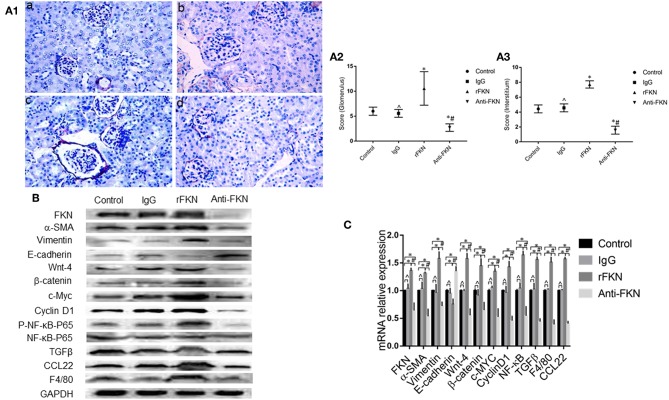
FKN is involved EMT and fibrosis via the Wnt/β-catenin pathway in the kidney of MRL/lpr mice. Histopathological features of renal tissue in the MRL/lpr mice model were studied by PASM staining (original magnification, ×400). (a) Control group;(b) IgG group; (c) rFKN group; (d) anti-FKN group. (A1) Assessment of glomerular and renal interstitial pathologies stained with PASM. Glomerular pathology was graded from the sum of scores for glomerular inflammation, thickness of basement membrane, epithelial cell reactivity, crescent formation, and necrosis. Interstitial pathology was graded using the sum of scores for perivascular inflammation and inflammatory cell infiltration. Scores were graded as 0 to 4 (0, none; 1 mild; 2 moderate; 3 moderate-high; 4 high). (A2) the sum of score by PASM staining in the renal glomerular inflammation. (A3) the sum of score by PASM staining in the renal glomerular inflammation. Renal tissue extract (~50 μg) was resolved on SDS-PAGE and western blot analysis was performed using antibodies against FKN, vimentin, α-SMA, E-cadherin, Wnt-4, β-catenin, cyclinD1, and c-Myc. GAPDH was used as an internal control. Total RNA were extracted from renal tissue of mice. Then the RNA was reverse-transcribed into cDNA and the transcripts were quantified using real-time PCR. GAPDH was used as an internal control. NF-kB-P65 was used as an internal control group of P- NF-kB-P65. Western blotting (B) and qRT-PCR (C) was used to detect the protein and mRNA levels of FKN, vimentin, α-SMA, E-cadherin, Wnt-4, β-catenin, cyclinD1, c-Myc, P- NF-kB -P65, CCL22 and F4/80 in renal tissues. *p < 0.05 compared with the control group. No significant differences between IgG compared to the control group are indicated as *p > 0.05. Significant differences among the rFKN group and anti-FKN groups are indicated as #p < 0.05. Data are expressed as the means ± standard deviation (n = 3). Statistical analyses were performed using one-way ANOVA.